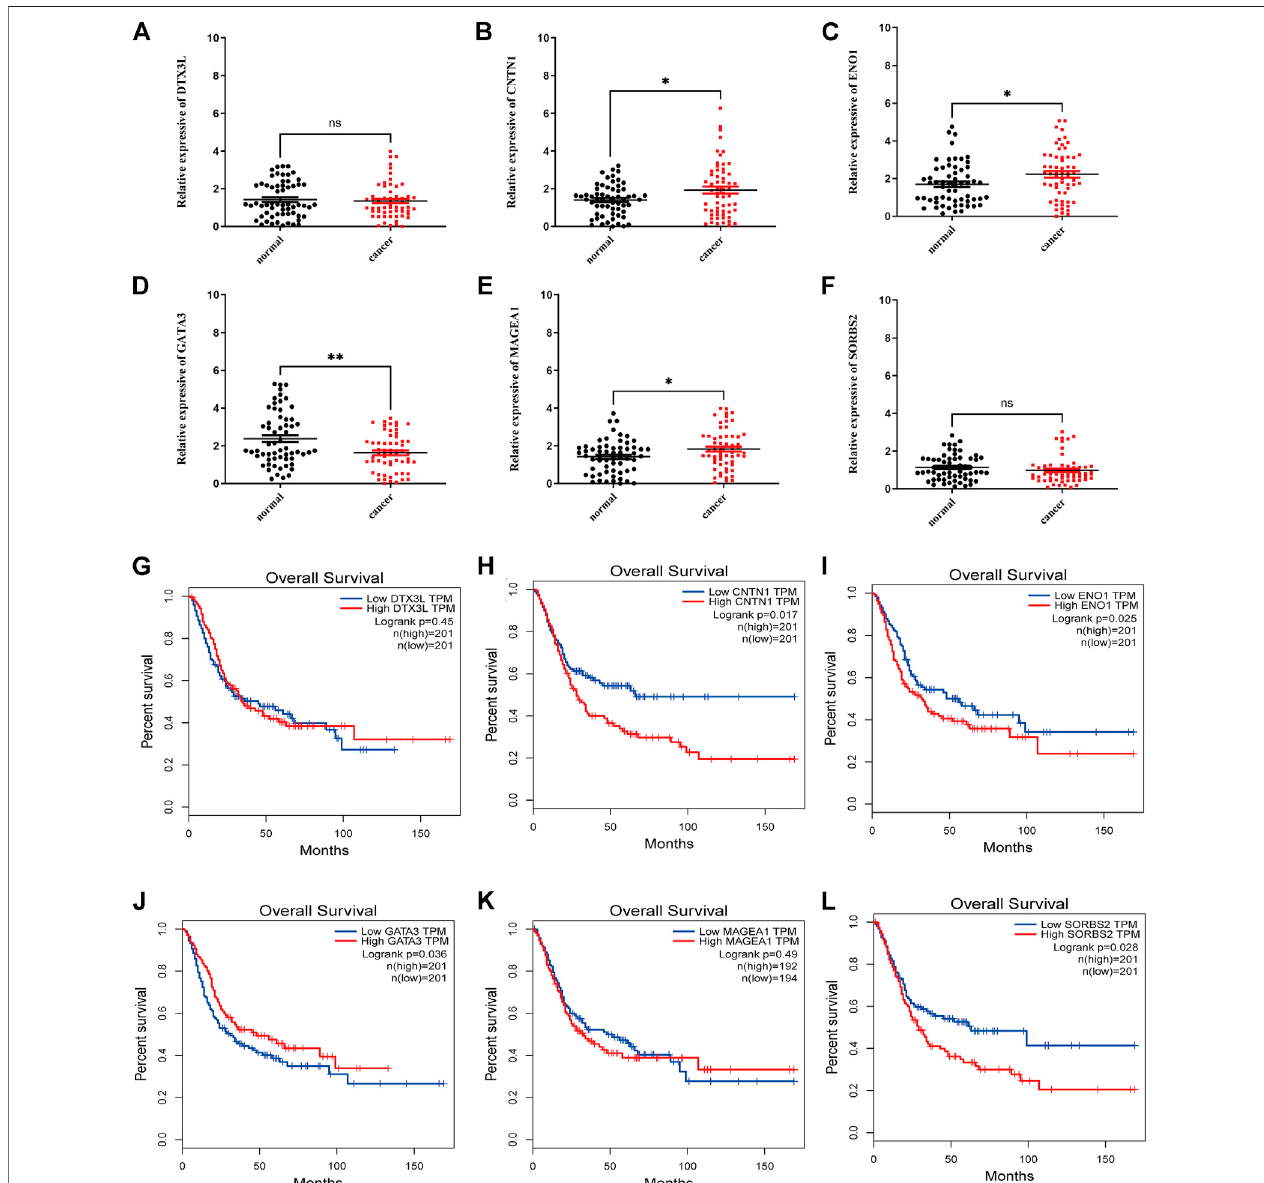
FIGURE 10 | Clinical validation of this risk model genes. qRT-PCR analysis of DTX3L, CNTN1, ENO1, GATA3, MAGEA1, and SORBS2 mRNA levels in tissue samples (A – F) . (G – L) GEPIA survival analysis of the six genes. * p < 0.05, ** p < 0.01,*** p < 0.001, ns p > 0.05.